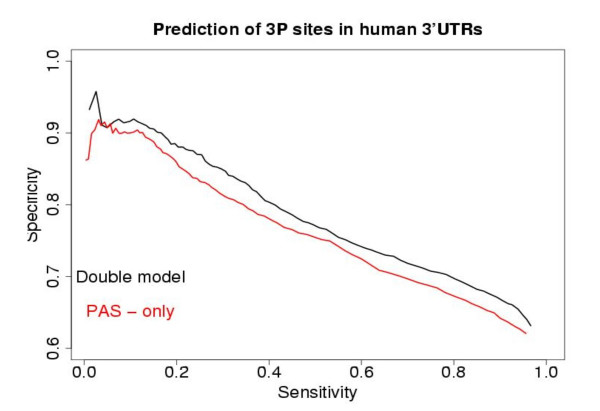
Sensitivity and specificity of mRNA CS prediction human 3'000 bases long 3'-UTRs for varying PLP thresholds using the double model shown in Figure 4A (black curve) compared to the PAS model (4B), (red curve). Sensitivity = TP/(TP + FN), Specificity = TP/(TP + TN).